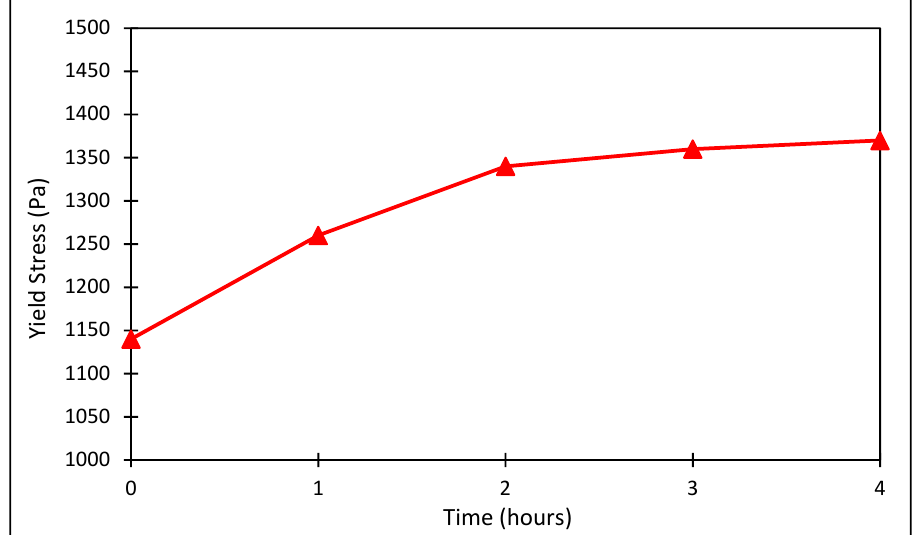
Figure 24. Rheology curves of mixture VII at different times after mixing.